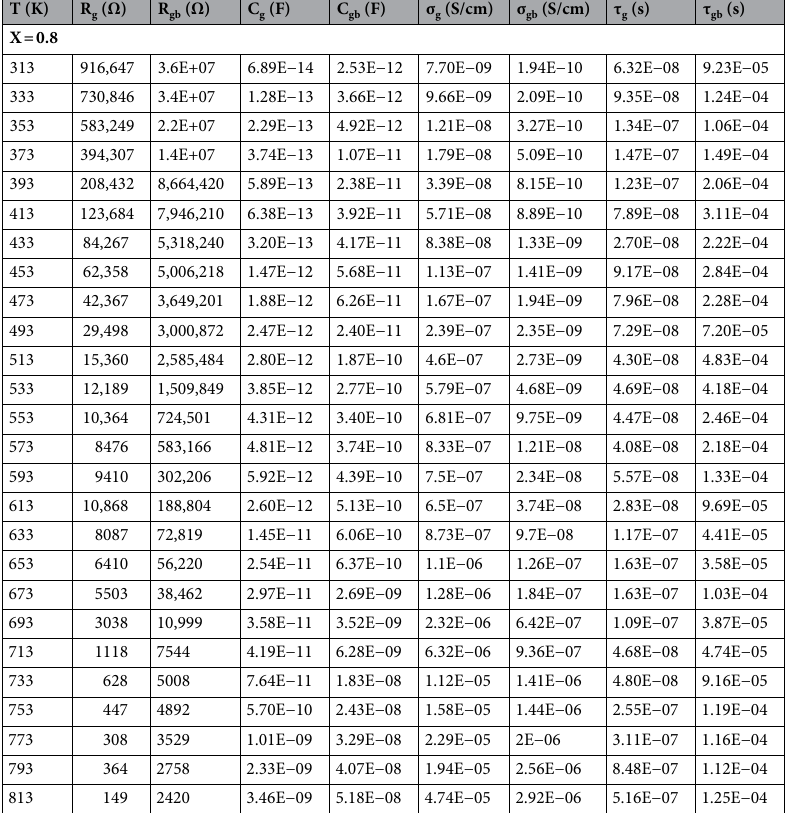
Table 7. Impedance spectroscopy parameters of X = 0.8